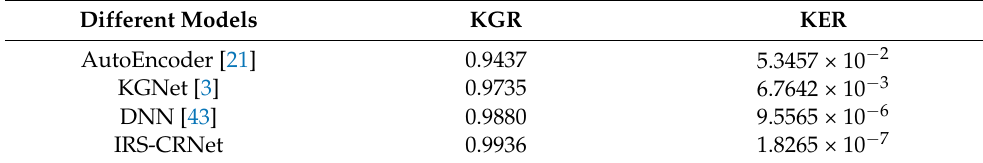
Table 5. Performance of different models.